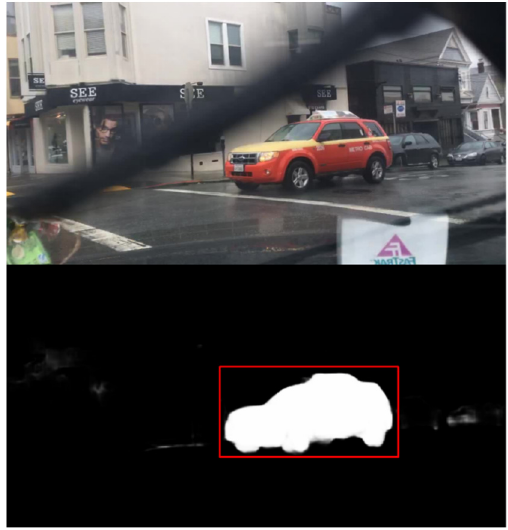
Figure 6. There is only one salient object in the traffic scene. Its confidence is judged to be a car is 0.928. Table 6. The relationship between the imaging of the salient object contours and the recognizability of the salient objects.